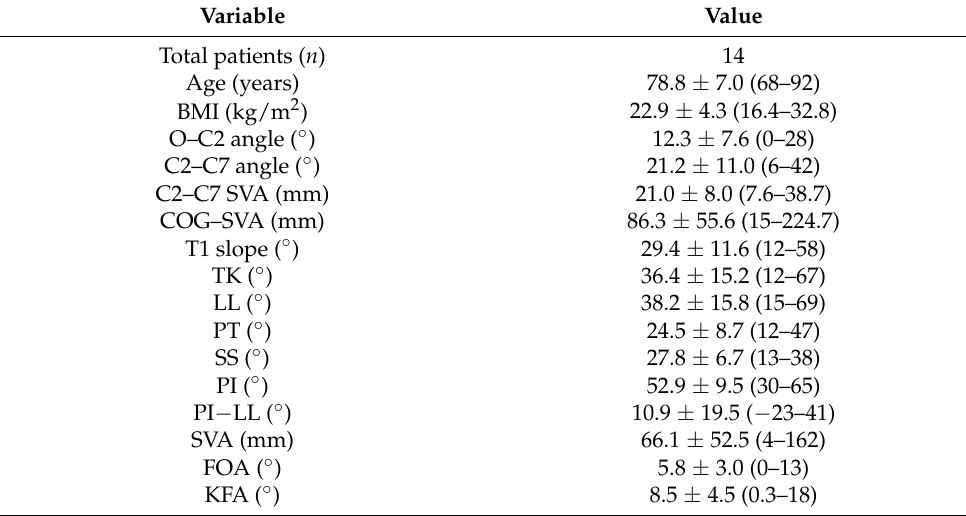
Table 1. Clinical information of all patients.